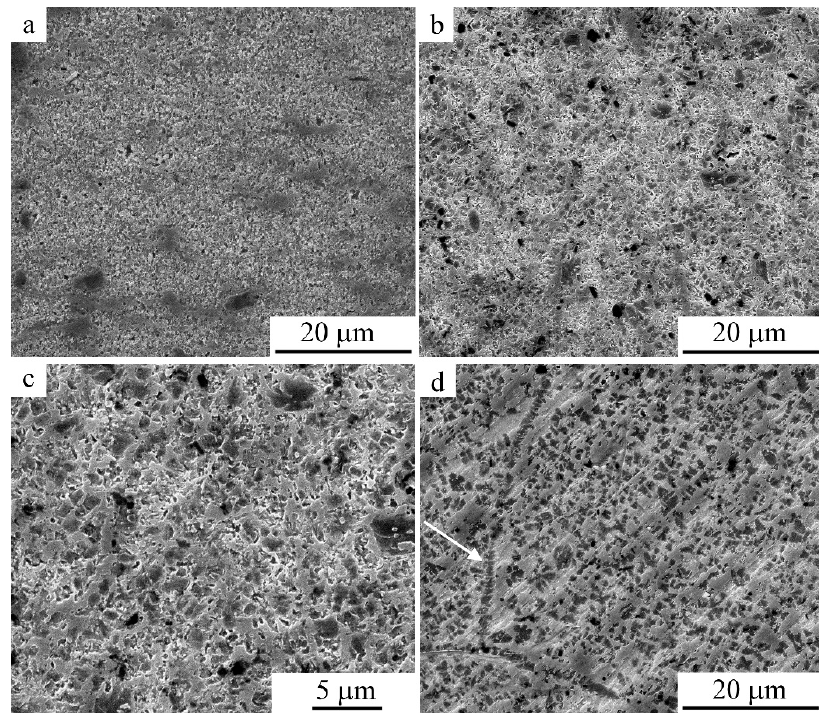
Figure 7. Secondary electron SEM images of the intragrain microstructure in the Cu-14Al-4Ni alloy after the compression tests at 673 K (( a )— v = 5, ( b , c )— v = 1, ( d )— v = 0.5 mm/min).